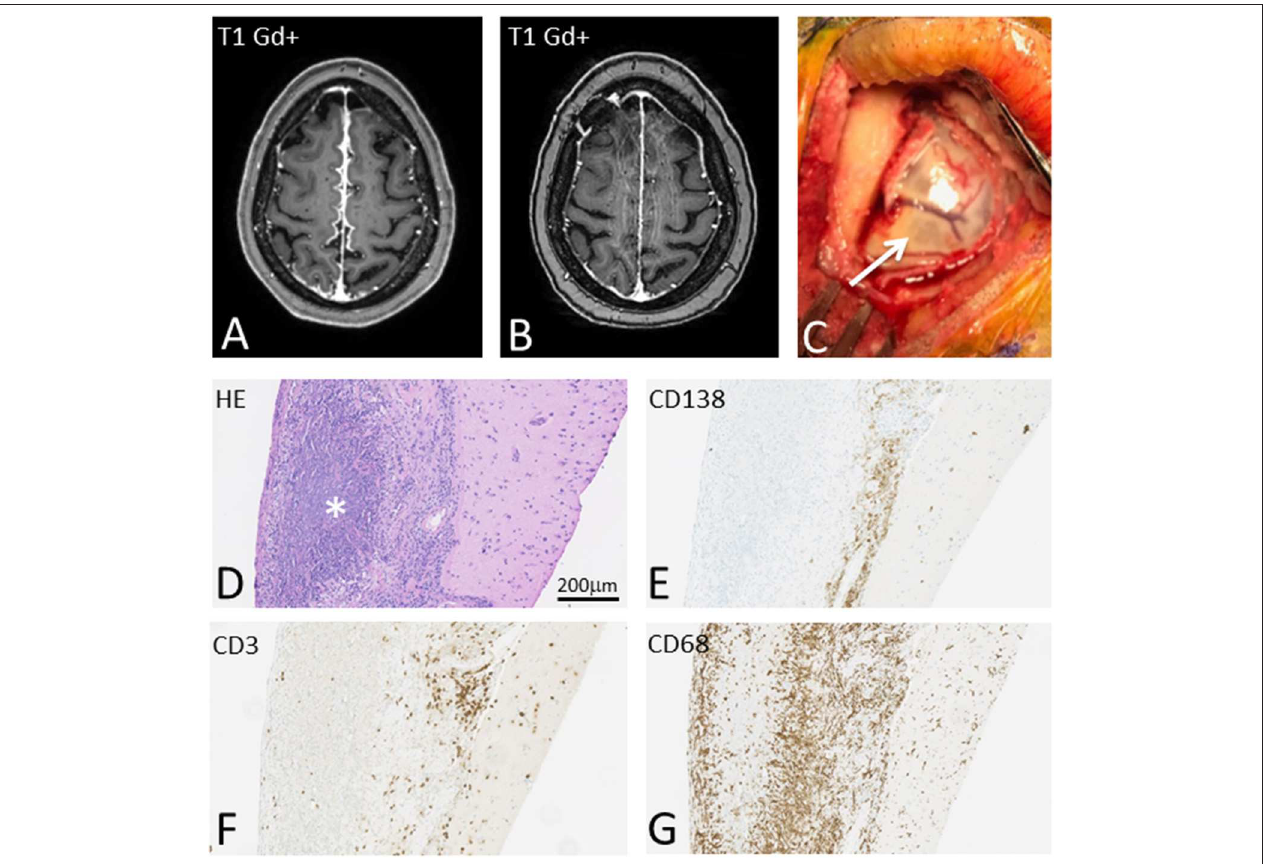
FIGURE 1 | T1-weighted brain MRI showing interhemispheric leptomeningeal Gd + enhancement before (A) and after (B) treatment with high dose steroids, Methotrexate and Rituximab. On gross inspection meninges appear severely inflamed (C) and pathological examination reveals massive meningeal granulomatous inflammation (D) with pre-dominant CD138 positive plasma cells (E) , but also CD3 positive T cells (F) . Massive infiltration with CD68 positive histiocytes with rheumatic granuloma formation was also seen (G)